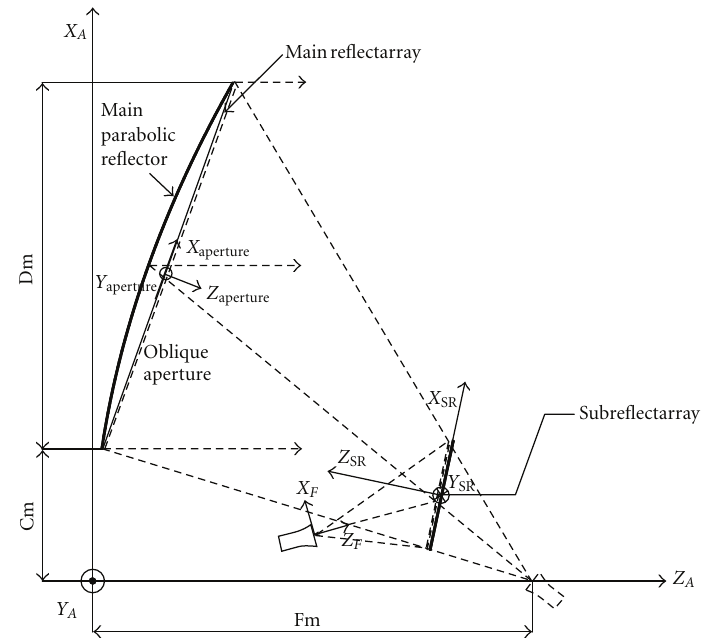
Figure 1: Scheme of dual-reflector antenna with a reflectarray subreflector and with a parabolic main reflector or a flat reflectarray as main